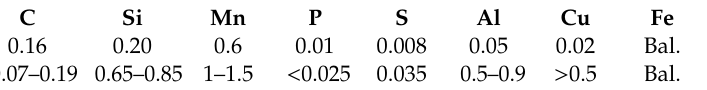
Table 2. Chemical composition